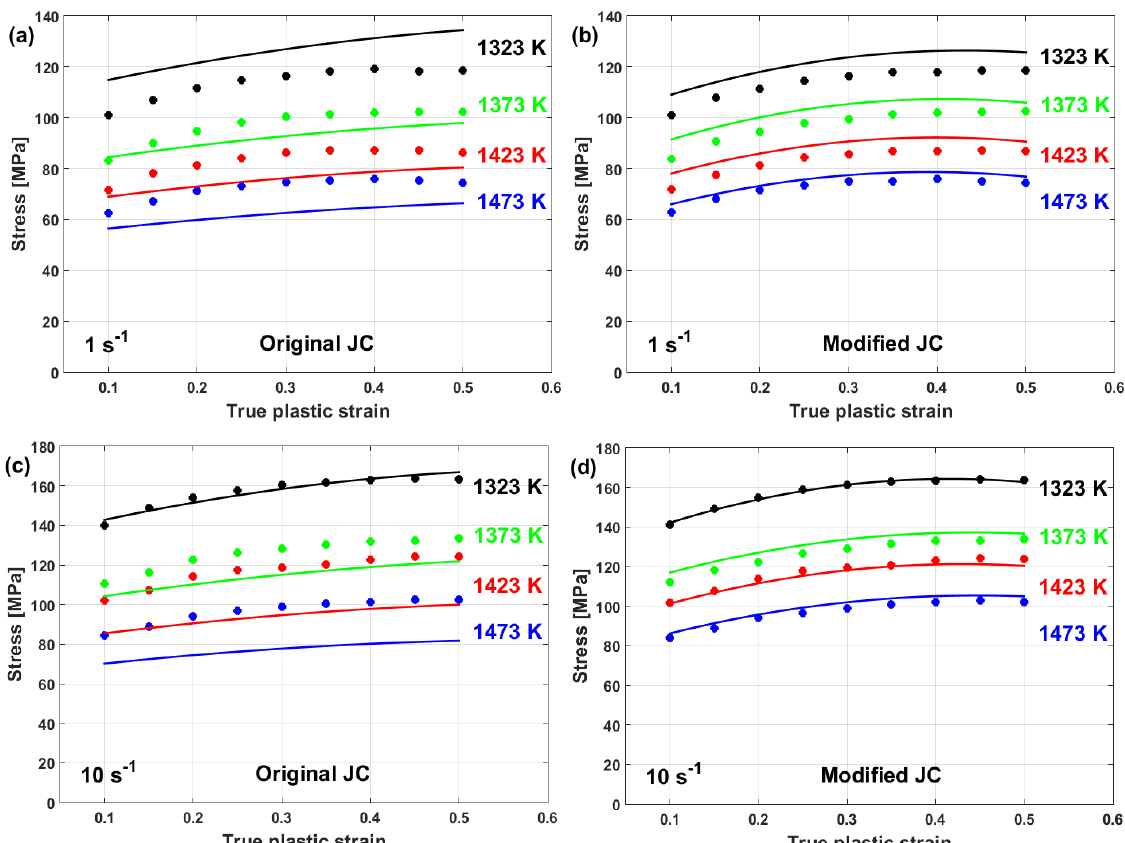
Figure 25. Comparison between experimental stresses (markers) and predicted stresses (solid lines) of T24 steel under hot deformation obtained by ( a , c ) the original JC model and ( b , d ) the modified JC model that was presented by Li et al. [80].